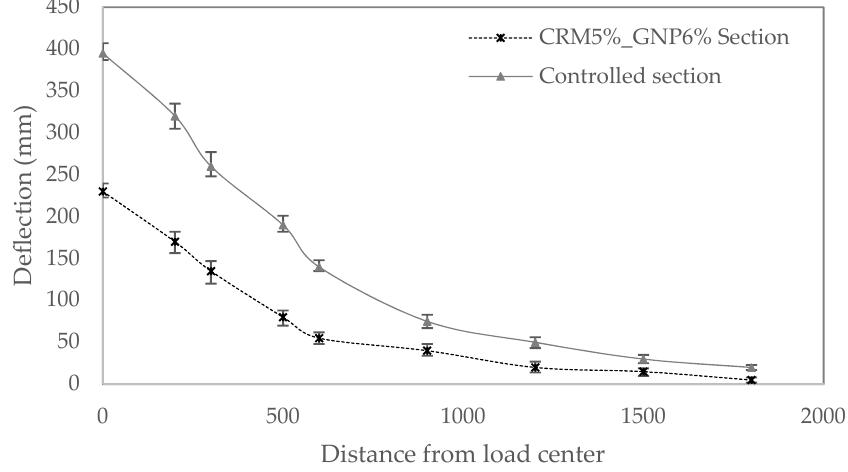
Figure 17. FWD method analysis: deflection data.